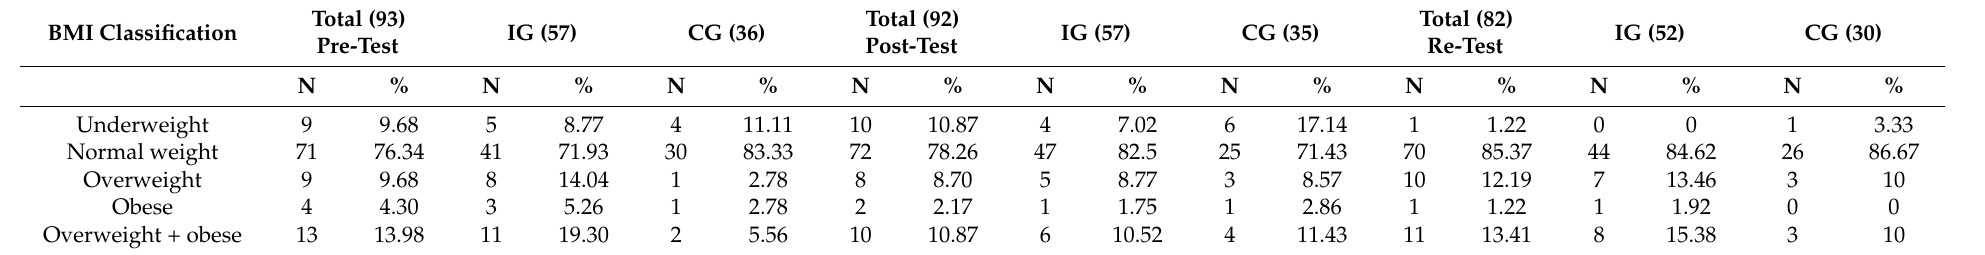
Table 4. Descriptive summary of the classification of the intervention group (IG) and control group (CG) in different BMI categories from pre-testing to